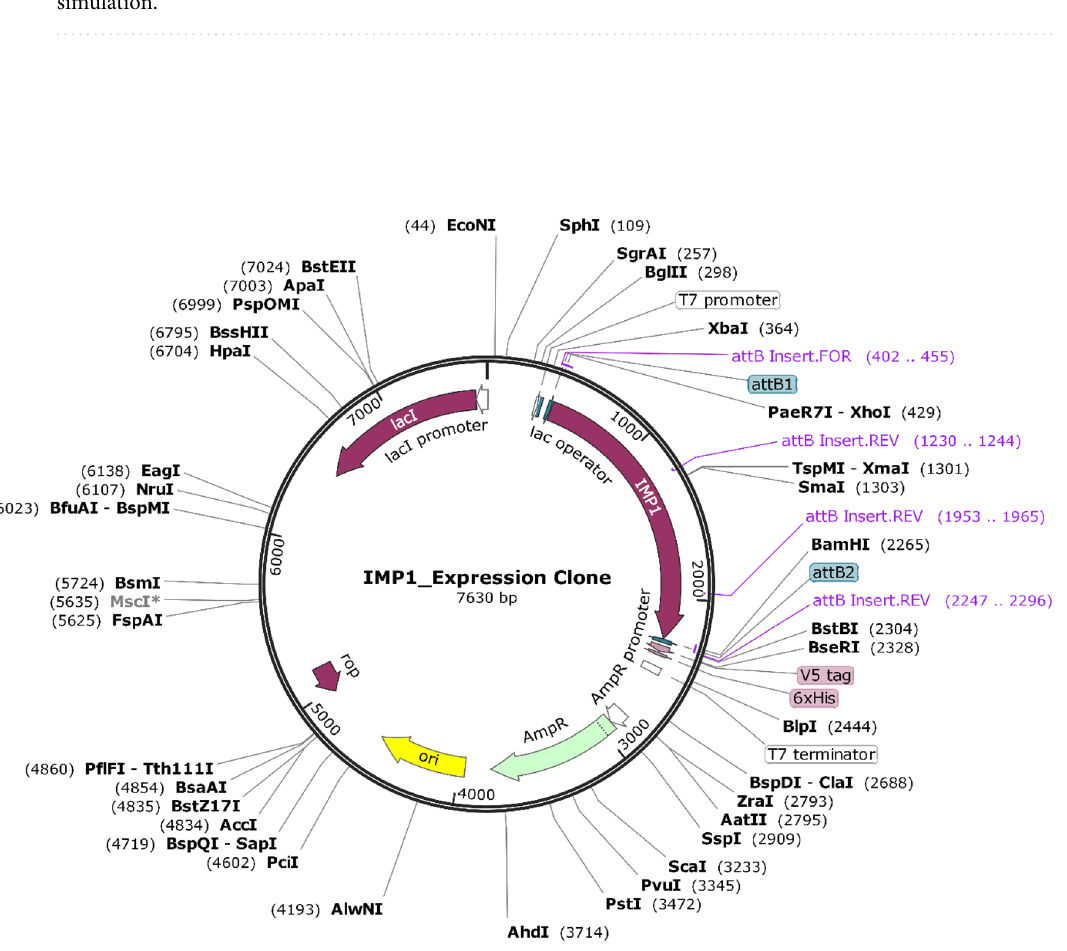
Figure 5. In silico cloning map for improved multiepitope sequence into petDEST42 vector, showing multiepitope vaccine labelled as IMP1 connected with XhoI (429) at C terminal and BamHI (2265) N